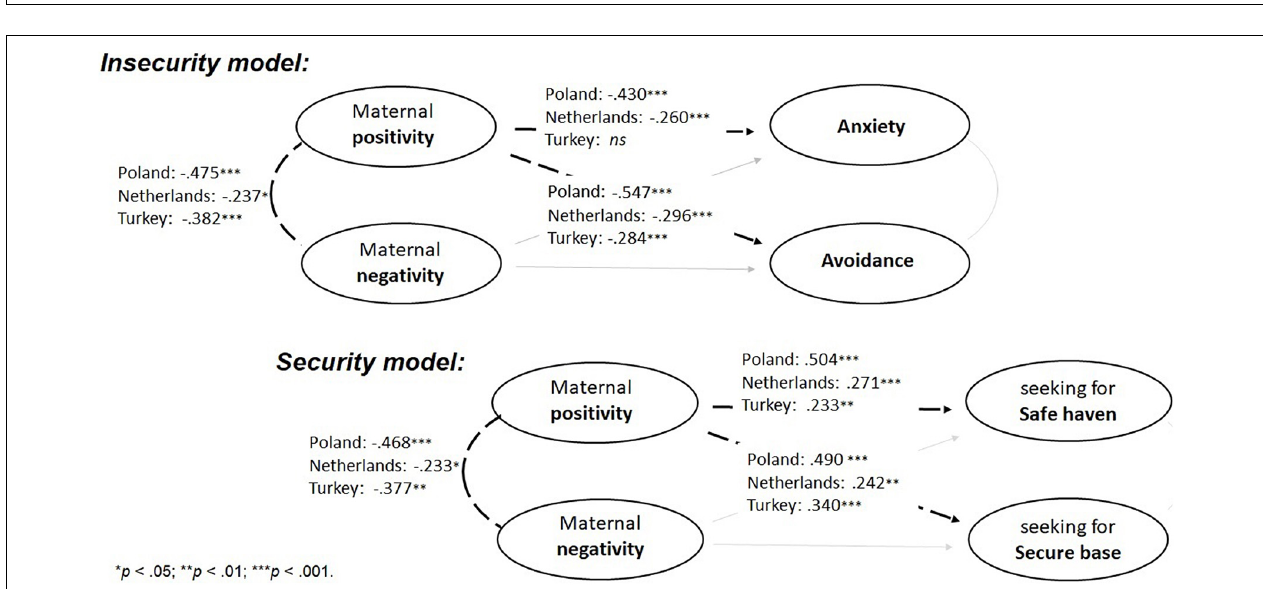
FIGURE 1 | Relations between maternal positivity, negativity and child’s attachment avoidance and anxiety (Insecurity model) and seeking the mother as a secure base and a safe haven (Security model) in the total sample. All relations are significant at the level of ∗∗∗ p < 0.001.